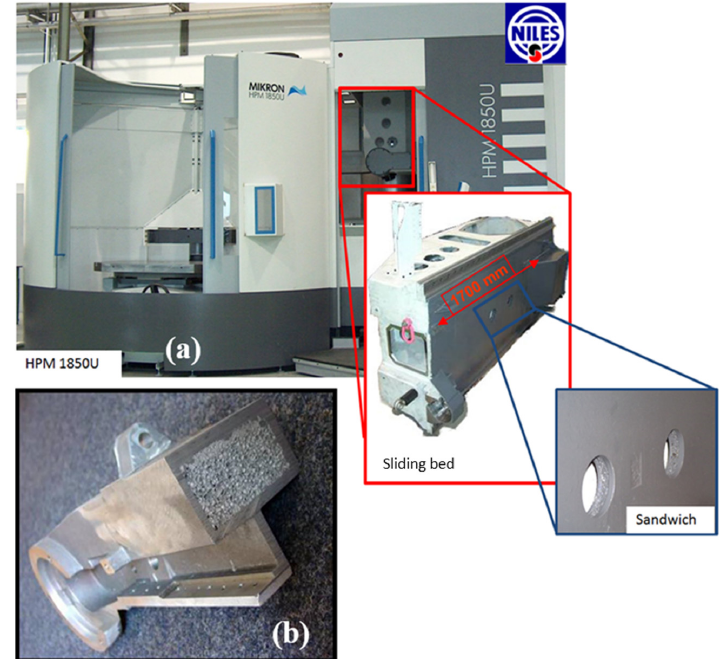
Figure 3. ( a ) Sliding bed of a milling machine made of welded aluminum foam sandwich (courtesy of Thomas Hipke, IWU, Chemnitz, Germany); and ( b ) a beam of a textile machine filled with Alporas foam (courtesy of the Au Metallgießerei, Sprockhövel, Germany).